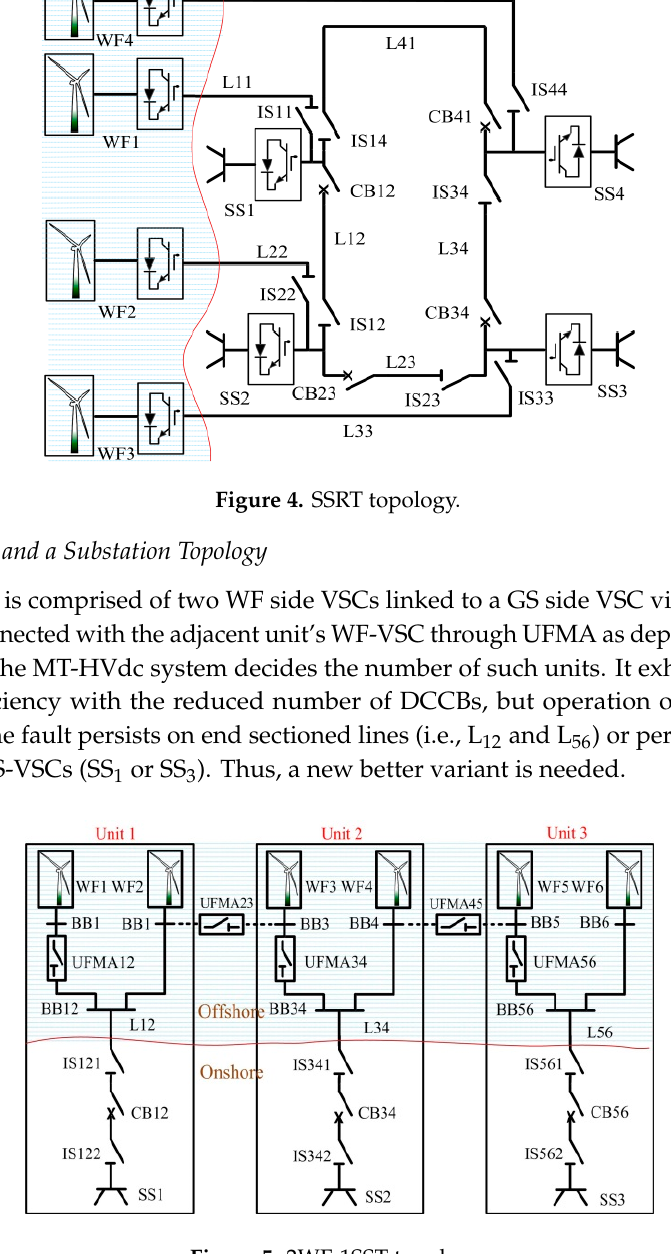
Figure 5. 2WF-1SST topology.